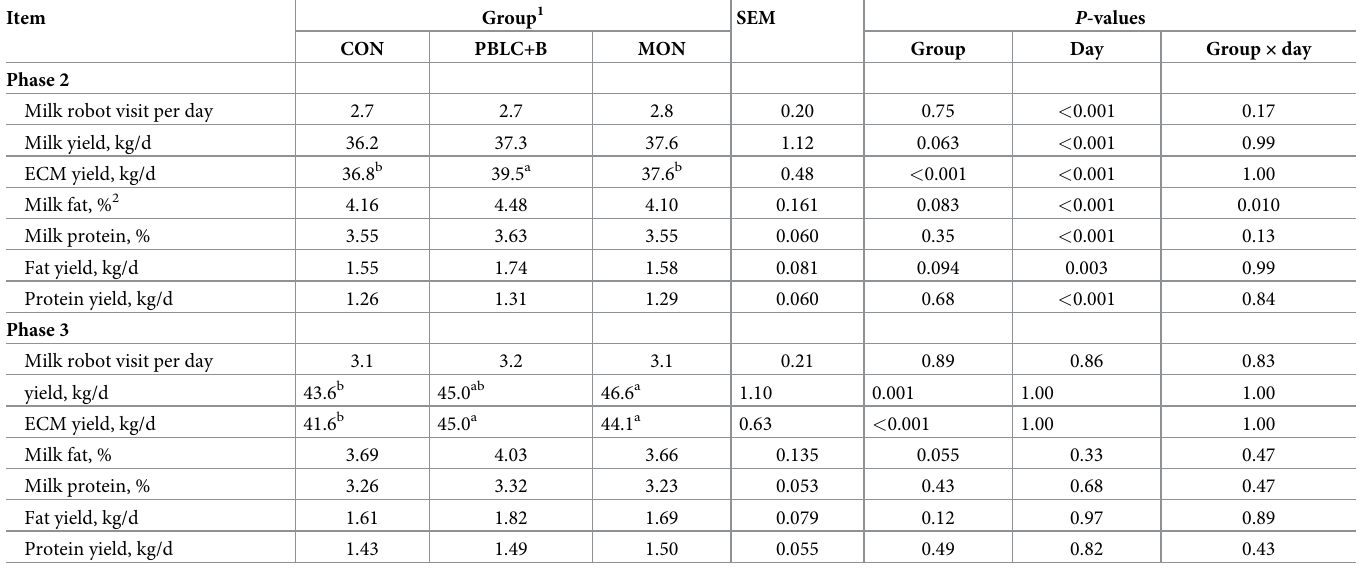
Table 4. Milk robot visits, milk yield and milk composition of cows receiving plant bioactive lipid compounds and biotin (PBLC+B; n = 18) from d -21 to d 37 rela- tive to parturition, cows receiving a monensin bolus (MON; n = 18) at d -21 or cows receiving no such supplements (CON; n = 17). Item Group 1 SEM